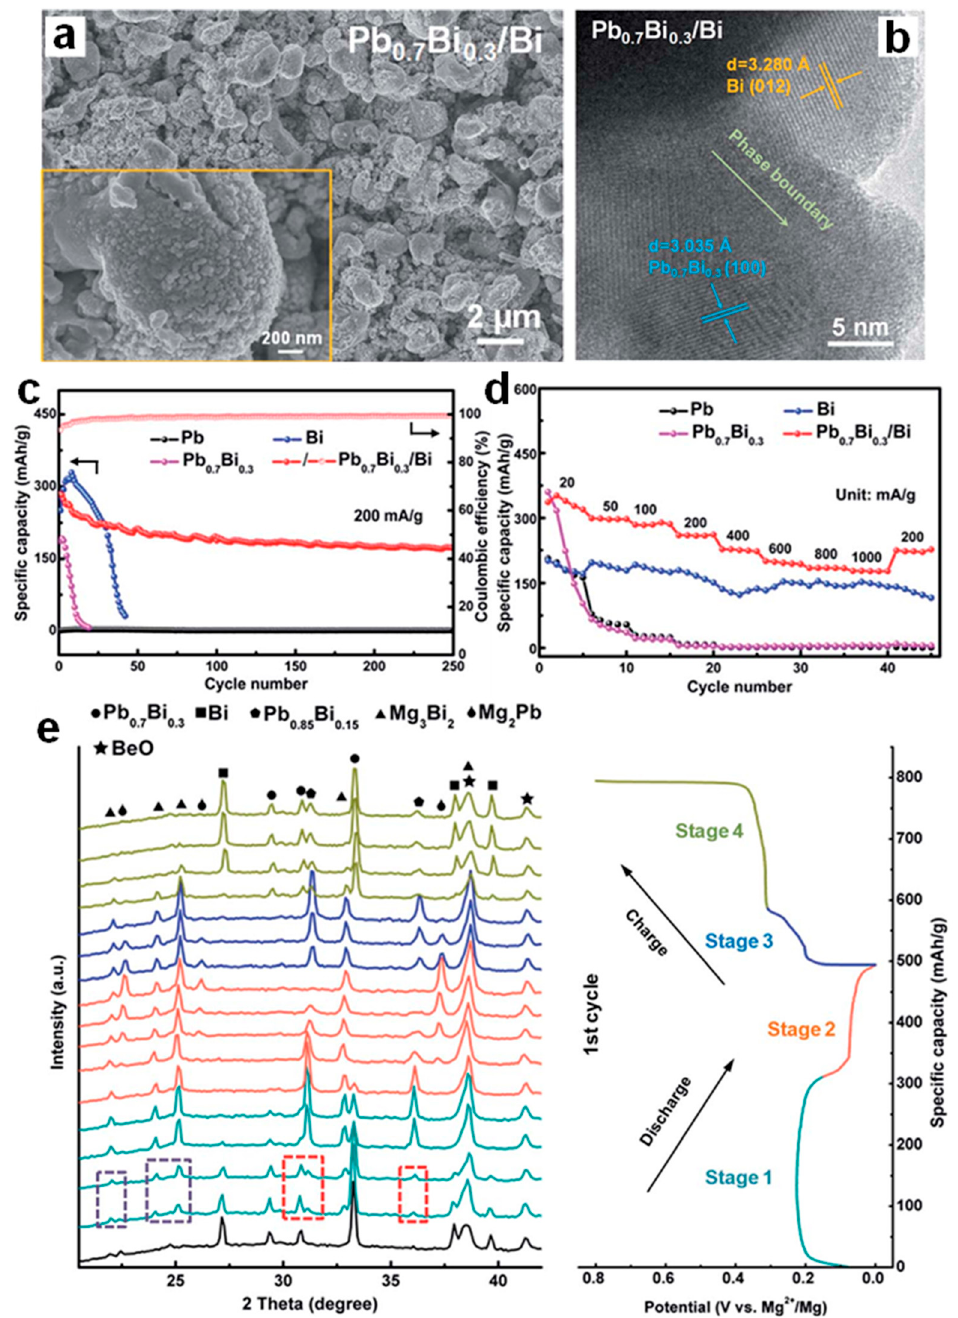
Figure 13. ( a ) SEM and ( b ) HRTEM images of the biphase Pb 0.7 Bi 0.3 /Bi film. ( c ) Cycling stability and ( d ) rate performance of the sputtered Pb, Bi, Pb 0.7 Bi 0.3 and Pb 0.7 Bi 0.3 /Bi electrodes. ( e ) Operando XRD results of the sputtered Pb 0.7 Bi 0.3 /Bi film during the first discharge/charge processes at 20 mA g − 1 . Reproduced with permission [51]. Copyright 2020, The Royal Society of Chemistry.